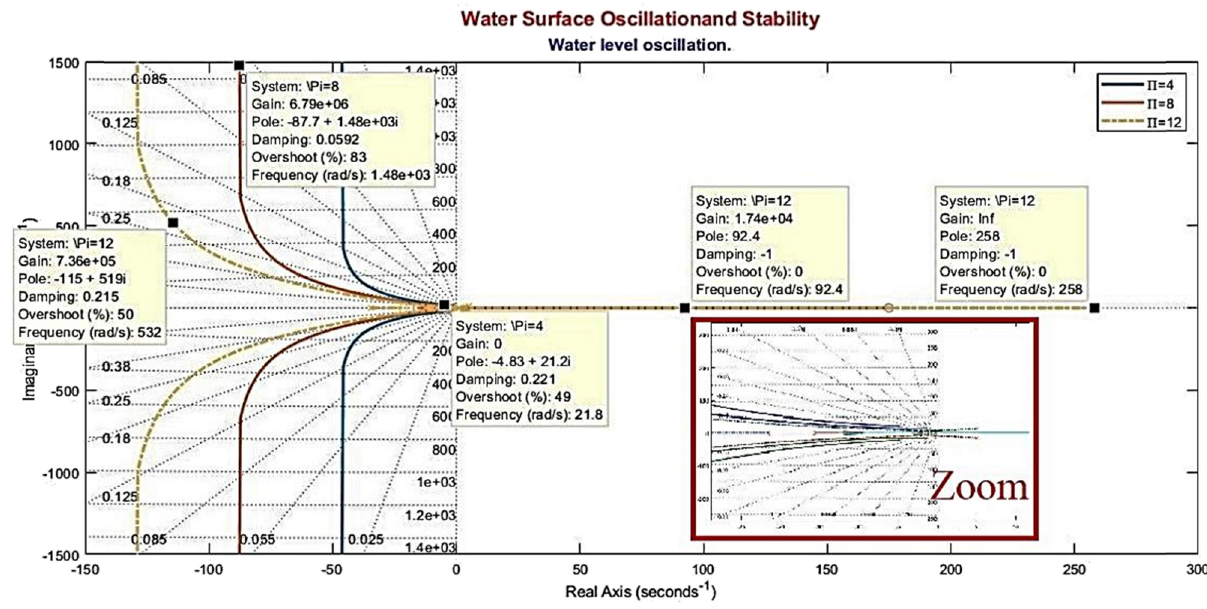
Figure 4: Stability of the system with di ff erent pressure e ff